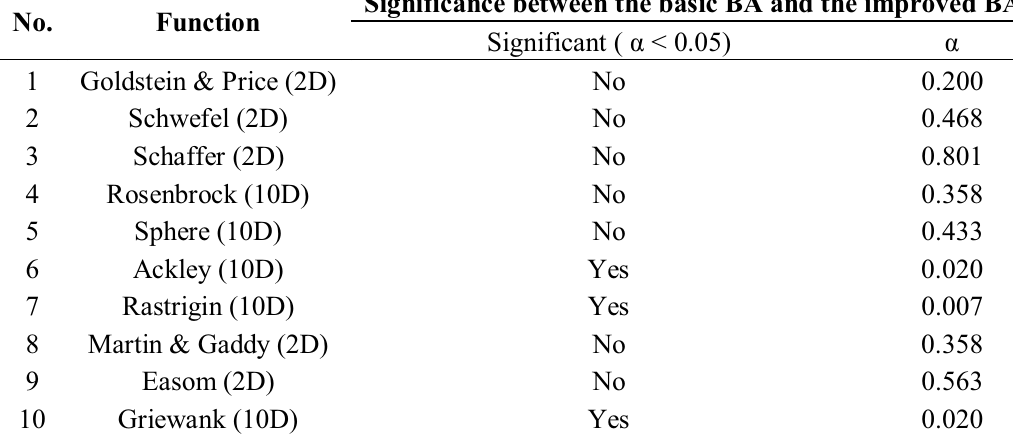
Table 10. The statistically significant difference between the adaptive neighborhood sizes and site abandonment in (ANSSA)-based BA and the basic BA. Significance between the basic BA and the improved Function